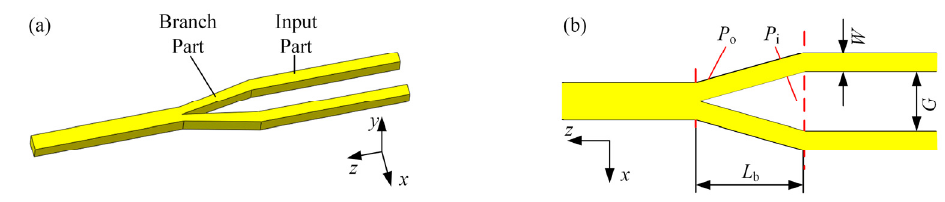
Figure 3. Structure of the Y-branch coupler. ( a ) Three-dimensional view; ( b ) Top view.